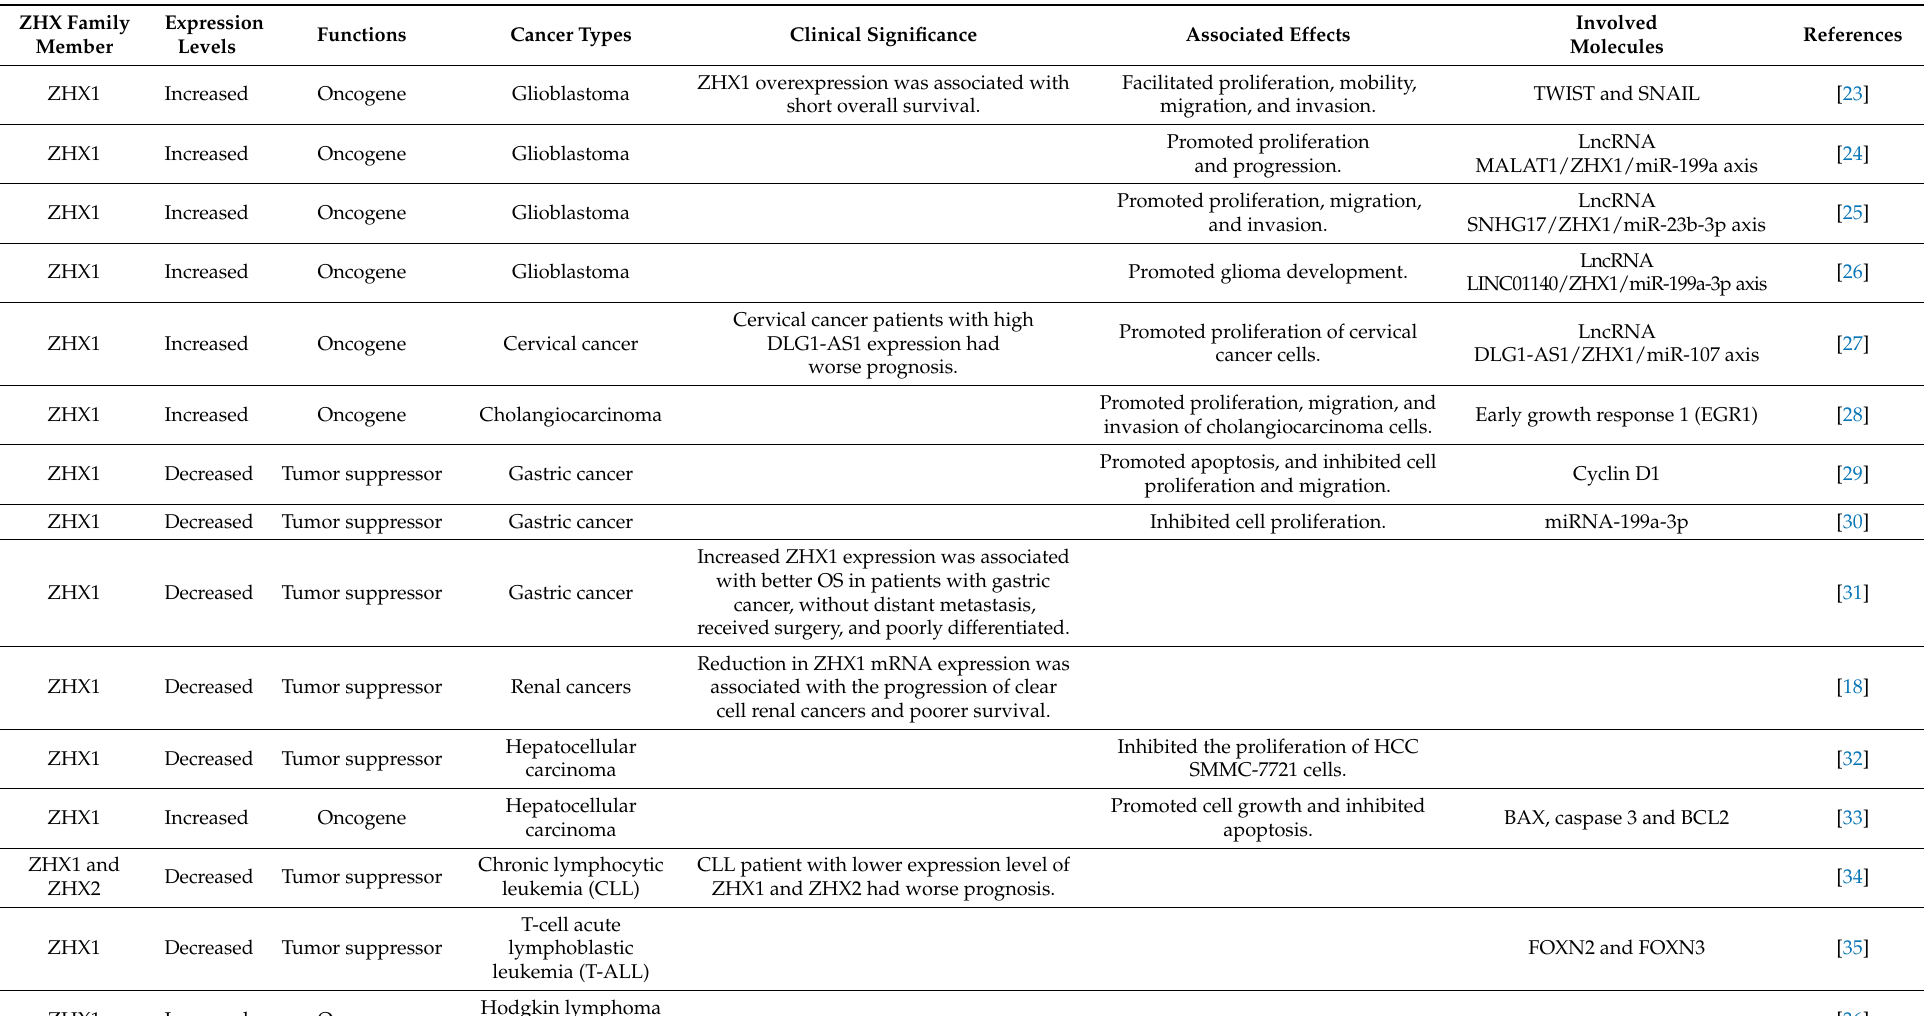
Table 1. Studies on ZHX1 expression, function, clinical significance, and molecular